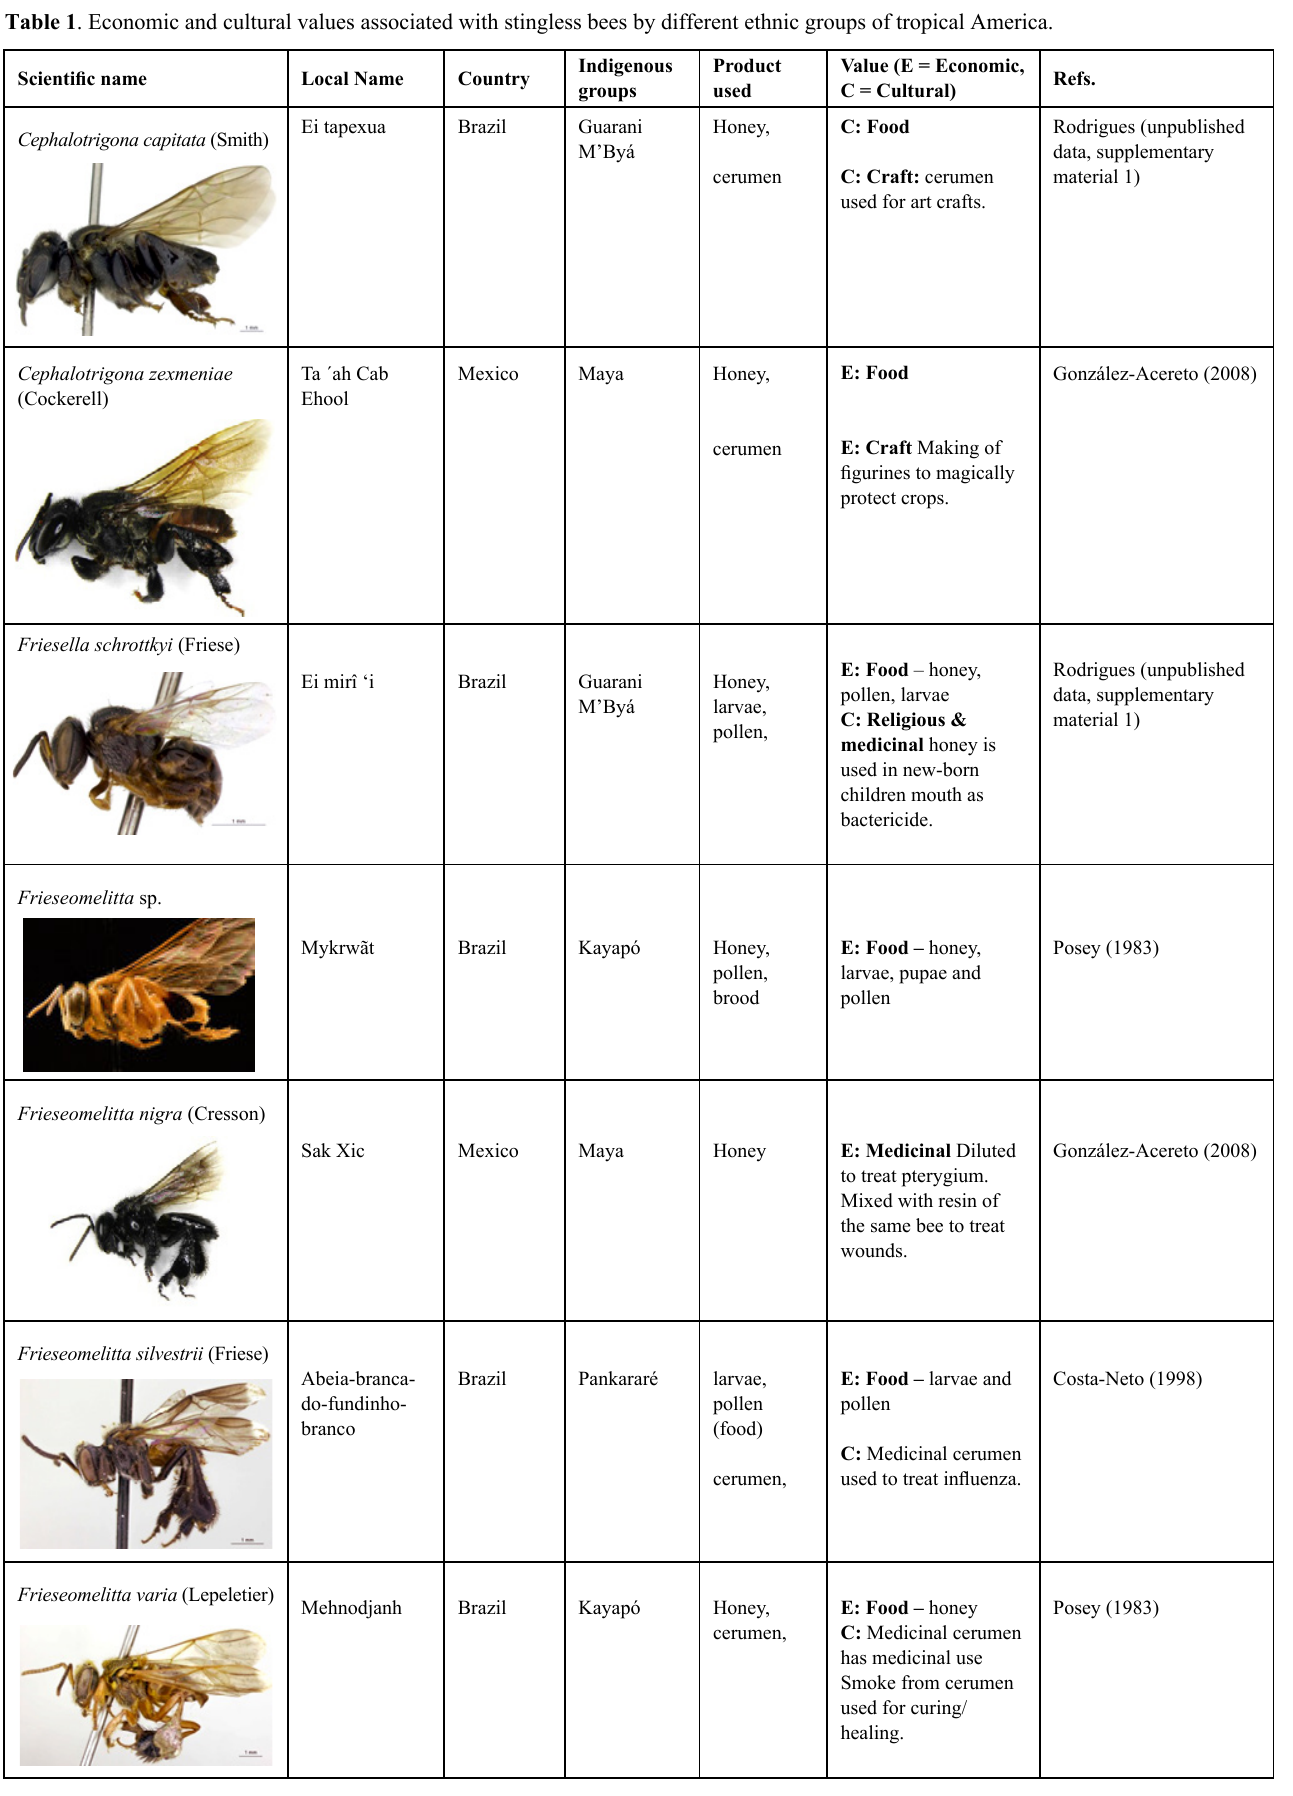
Table 1 . Economic and cultural values associated with stingless bees by different ethnic groups of tropical America. Scientific name